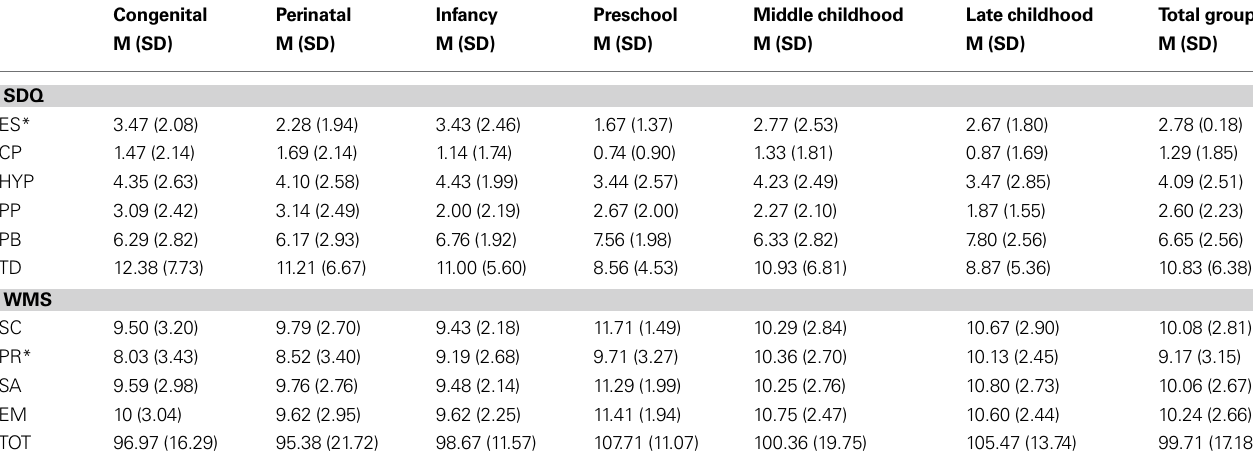
Table 4 | Differences in social functioning ratings across EBI groups. Congenital Perinatal Infancy Preschool Middle